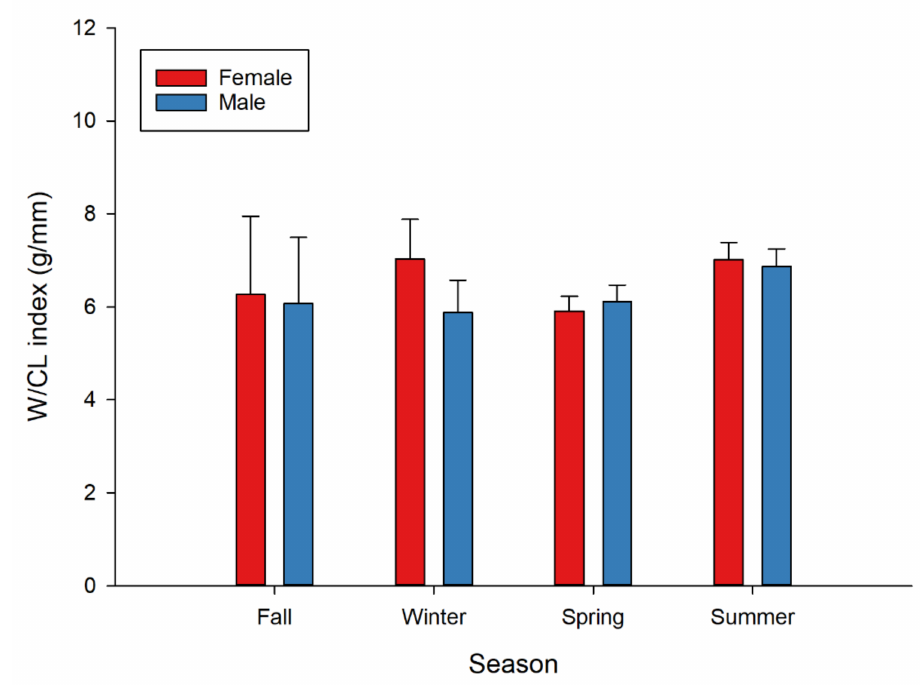
Figure 7. Seasonal variation in the W/CL index (condition factor) of female and male European lobster ( Homarus gammarus ). Error bars represent 95% confidence